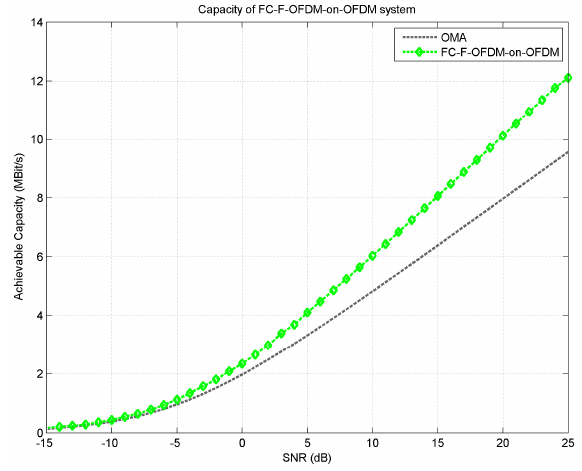
Figure 5. SINR vs total number of samples at SNR 5 dB and injection level − 5 dB, demonstrating comparative performance of RLS-FRESH and DDA-FRESH equalizers with regards to successive interference cancellation based NOMCR decoding.